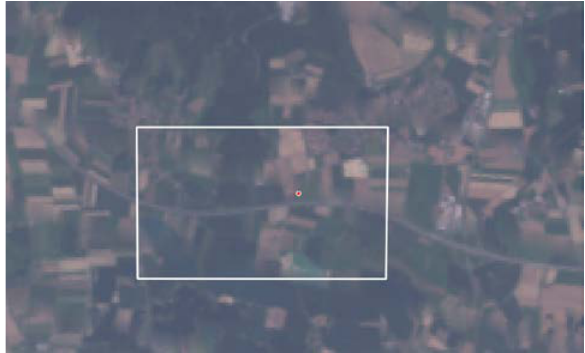
Figure 5 Detail of a Landsat image for day 234 of the year 2011 (white rectangle indicates borders of the aerial image from Figure 3)